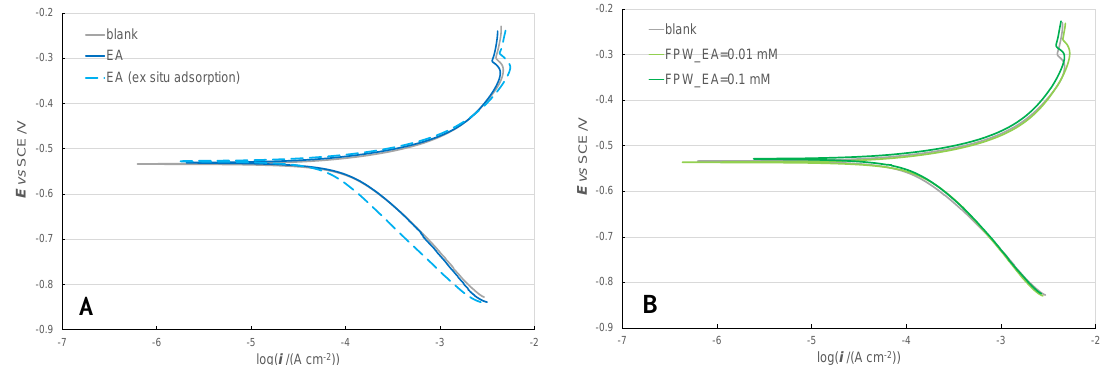
Figure 3. Potentiodynamic polarization curves (scan rate 0.5 mV s −1 ) of Armco ® iron electrodes in aerated 0.05 M HCl with 1 vol% methanol (grey lines). ( A ): with the addition of 10 µM ellagic acid (solid dark blue) and after 2 h of ex-situ immersion in 1 mM EA methanolic solution (dashed light blue); ( B ): with the addition of different concentrations of FPW extract. Electrolyte temperature: 30 °C.